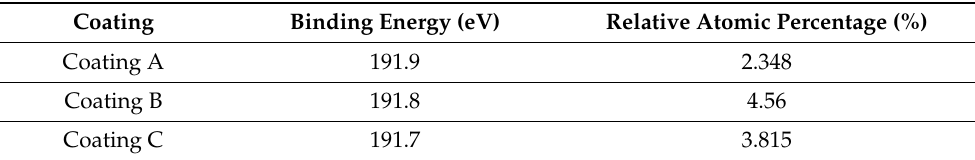
Table 5. Relative percentages of the B 2 O 3 phase present on the rake surface of the three TiB 2 coated tools after approximately 100 m cut obtained from High Resolution